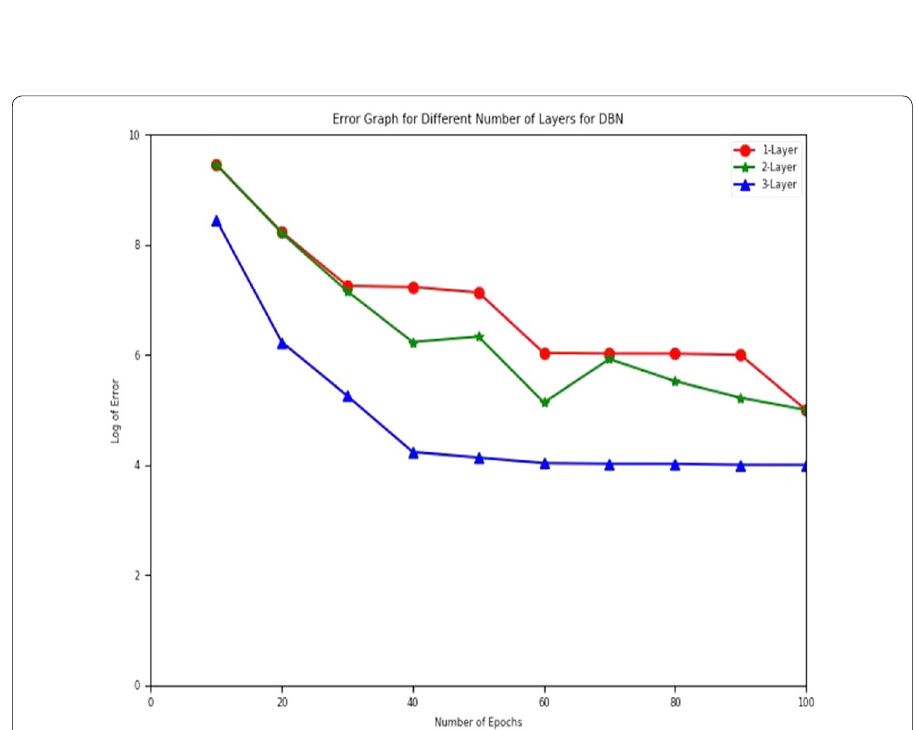
Fig. 4 Error graph for different number of layers for